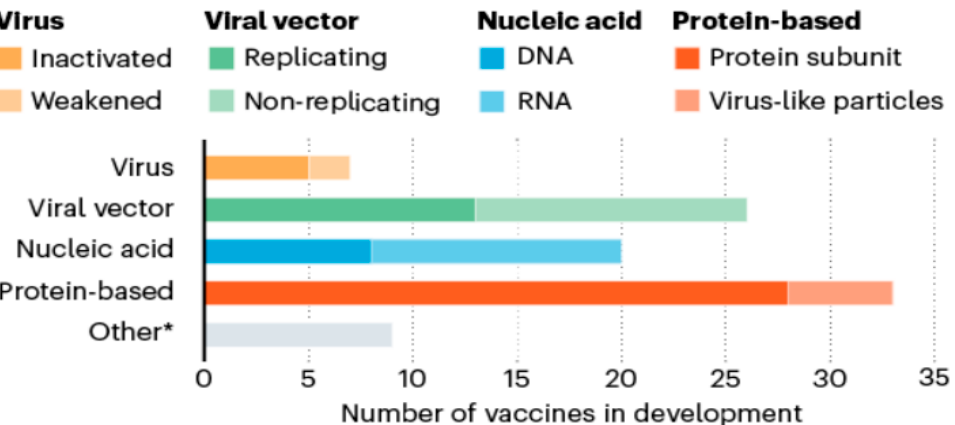
Figure 8. An array of vaccines: eight different approaches including viral-inactivated & weakened, viral vector-based replicating & non-replicating, protein-based subunit & virus-like particles are used for the development of SARS-CoV-2 (source: Nature Briefing).